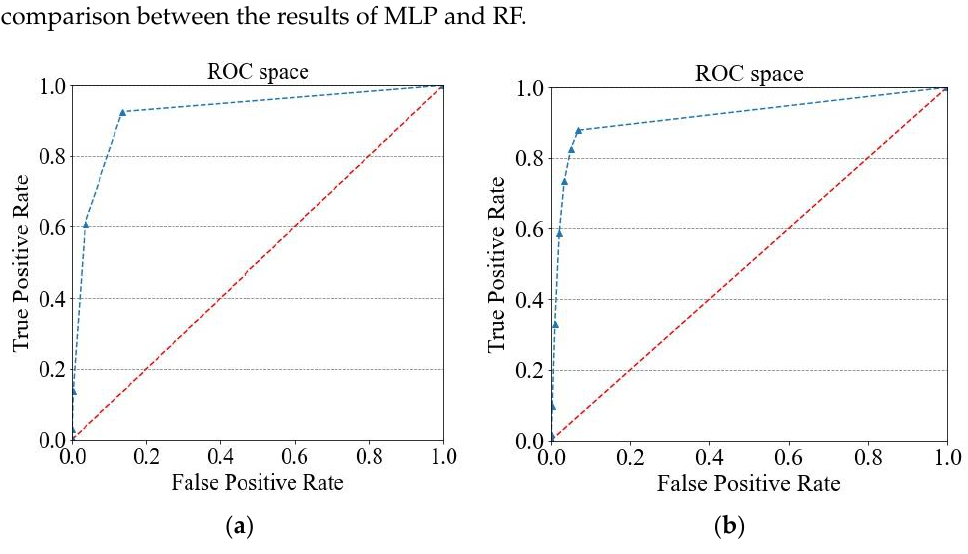
Figure 7. ROC curves from the evaluation of the two different strategies based on the STM-based model on Surat from ( a ) the one-year strategy and ( b ) the ten-year strategy.